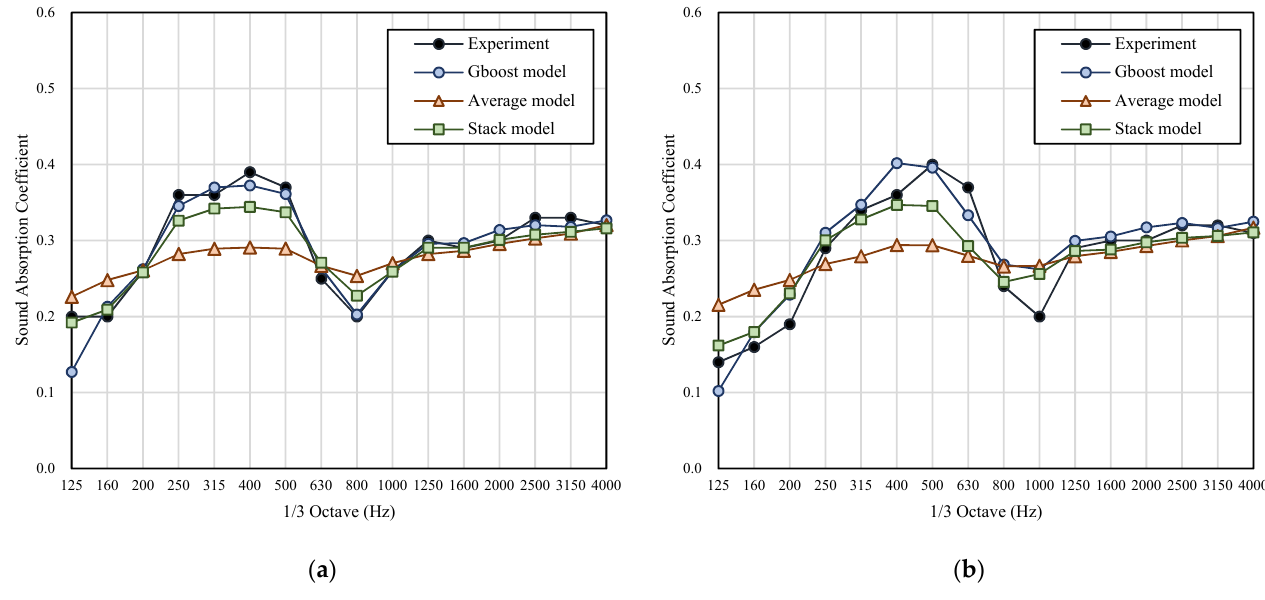
Figure 10. Results of machine learning models: ( a ) training set: case A2; ( b ) testing set: case A1.